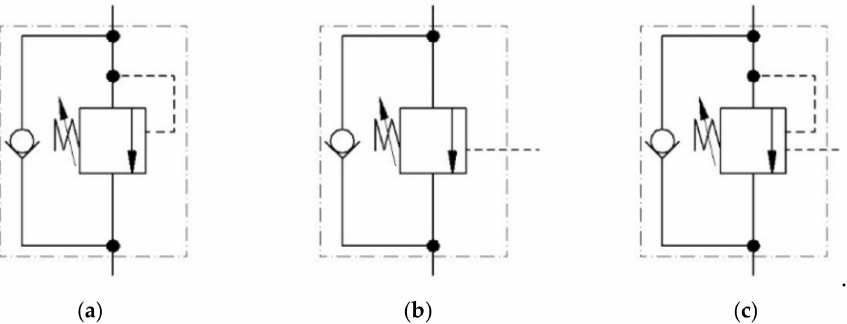
Figure 14. Counterbalance valve (CB) symbols: ( a ) internally pilot-operated (CB Int); ( b ) externally pilot-operated (CB Ext); ( c ) internally/externally pilot-operated (CB